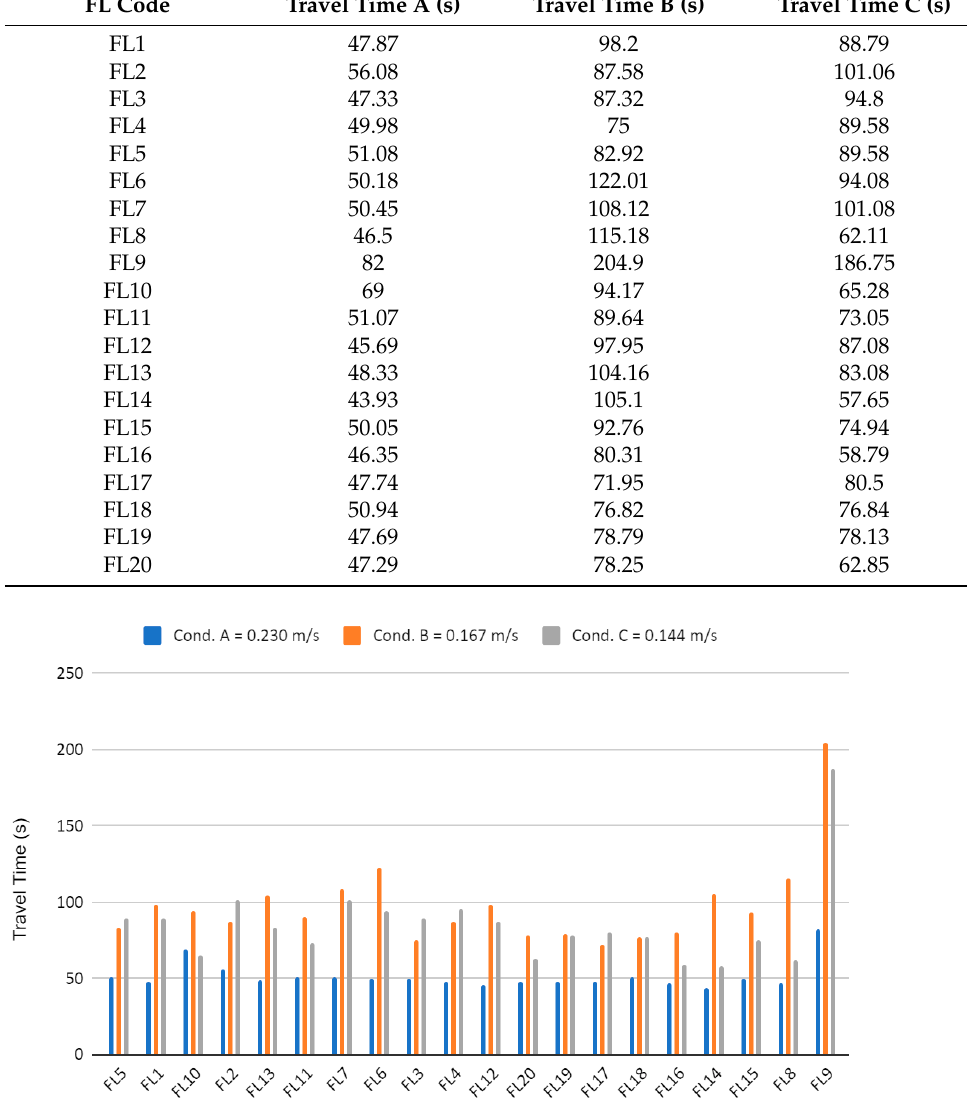
Table 4. The list of FL travel times during each